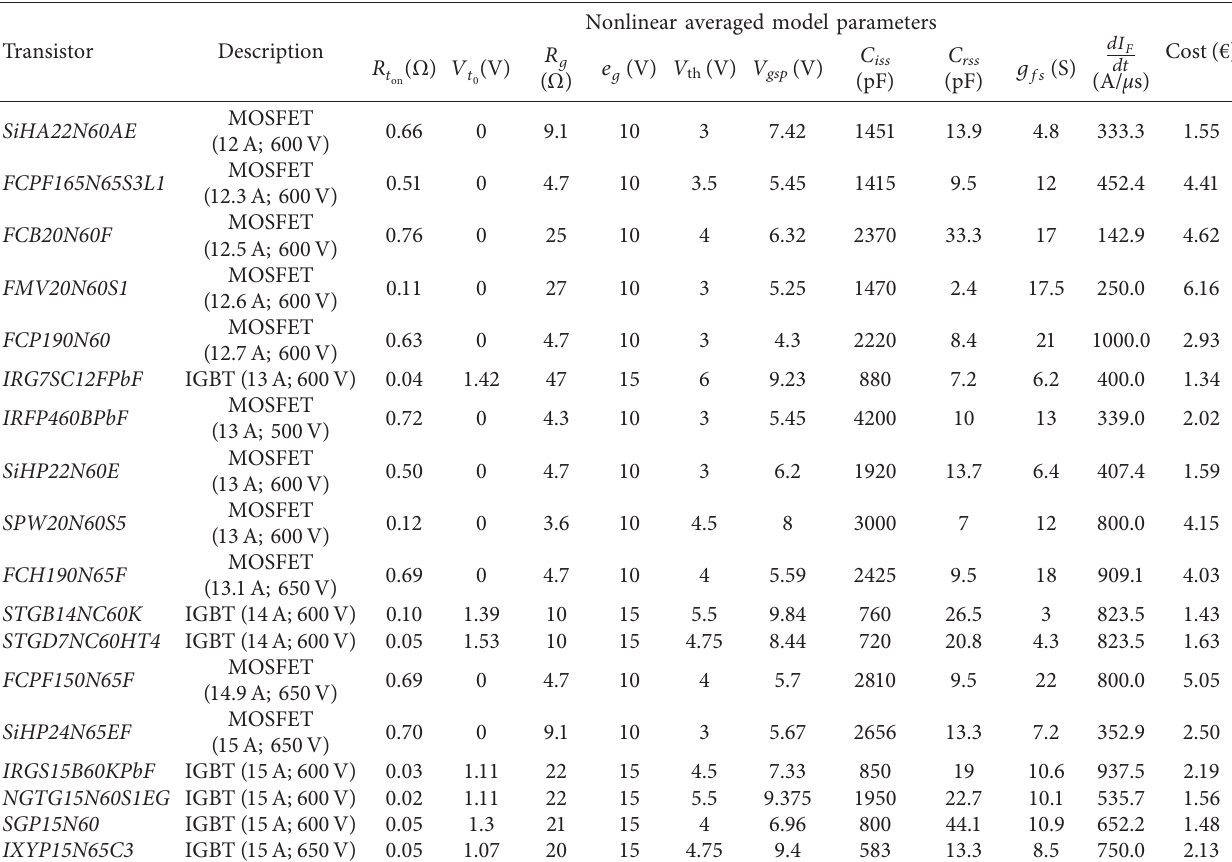
Table 2: Power transistor